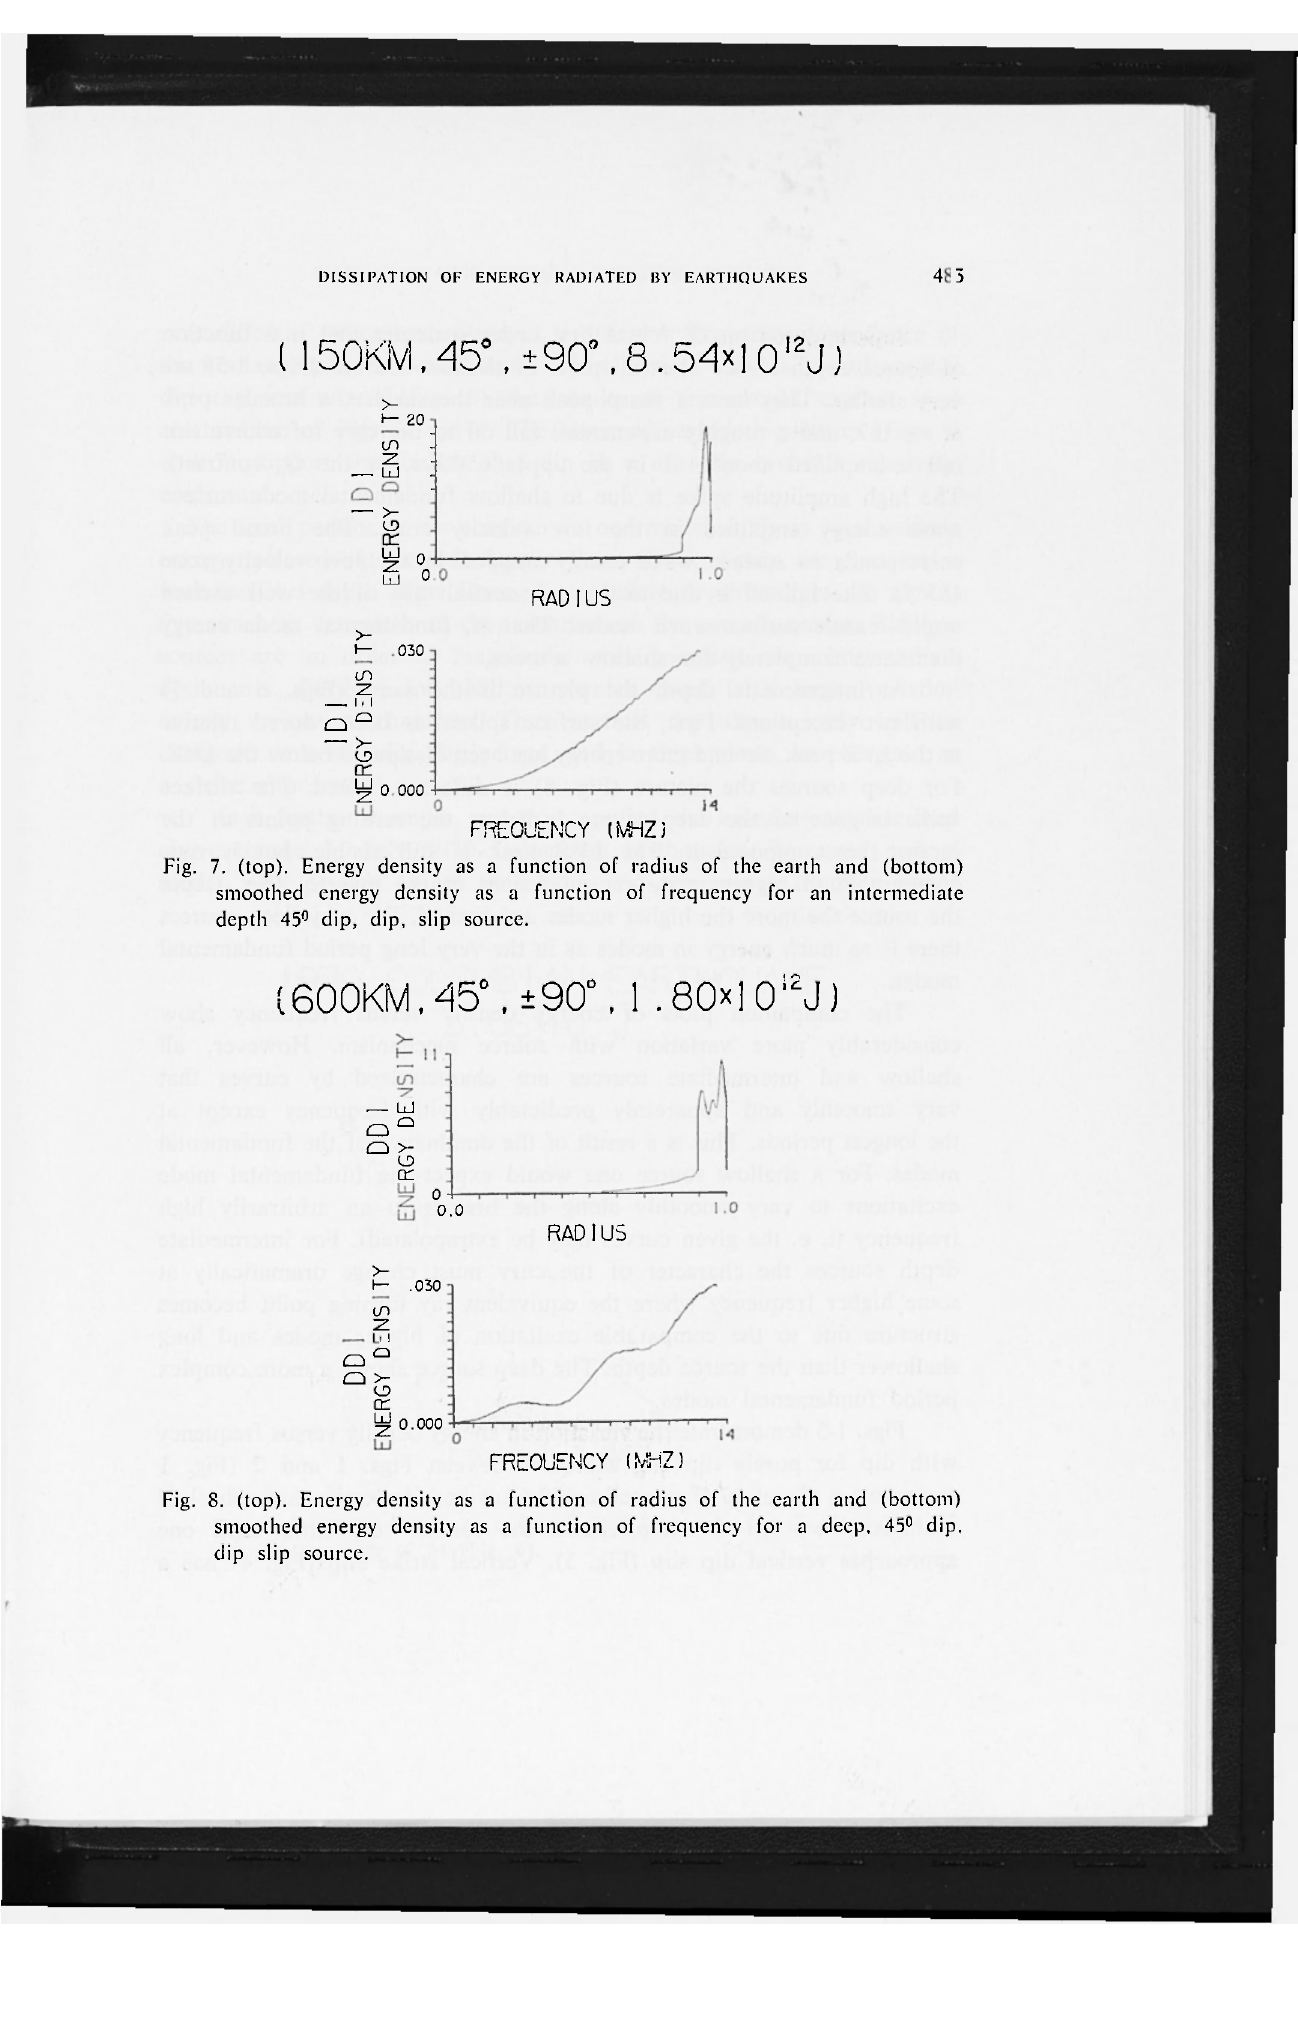
Fig. 7. (top). Energy density as a function of radius of the earth and (bottom) smoothed energy density as a function of frequency for an intermediate depth 45° dip, dip, slip source.